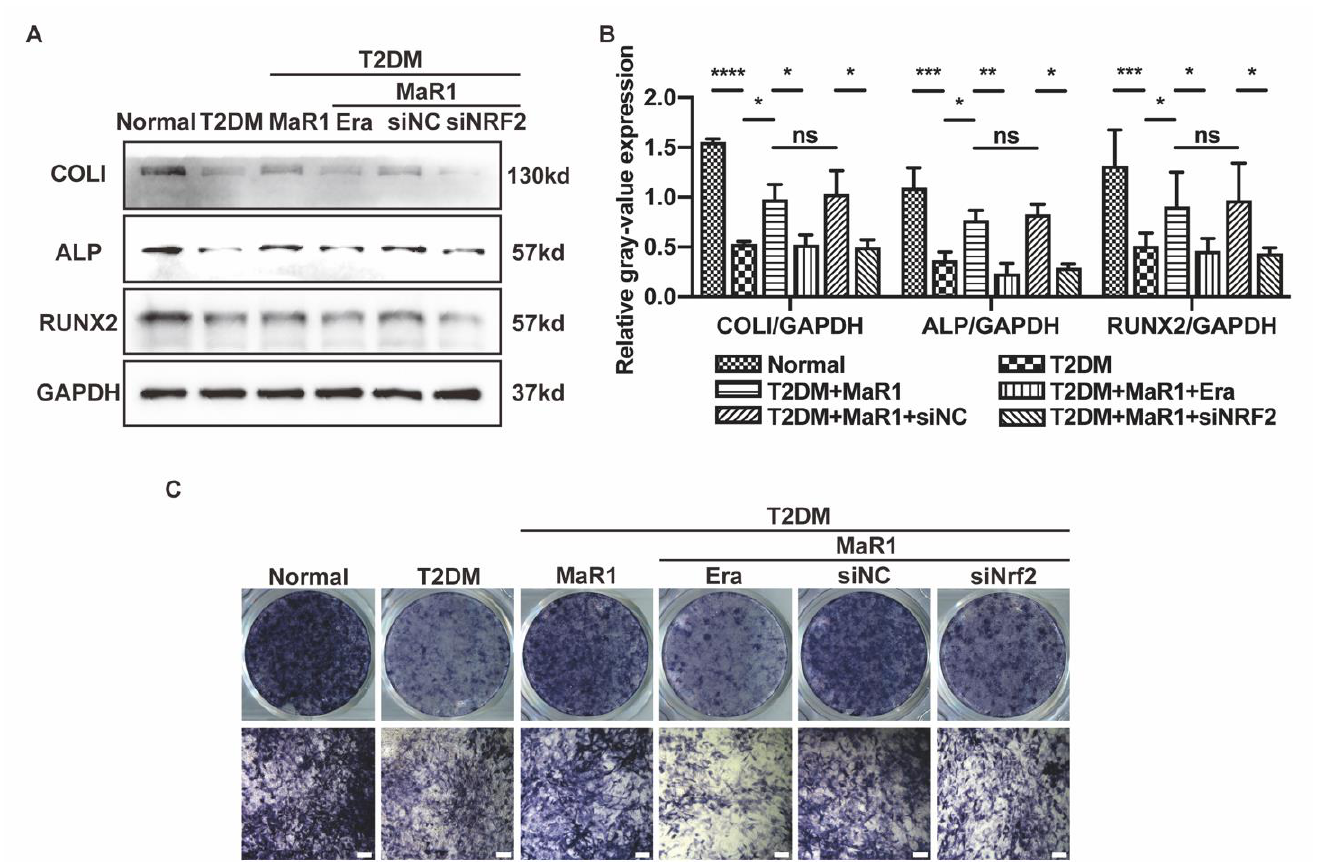
Figure A3. MaR1 protects against ferroptosis-mediated impairment of osteogenic differentiation of osteoblasts by modulating NRF2 signaling in T2DOP. ( A ) After seven days of osteogenic induction, the protein levels of COLI, ALP, and RUNX2 were determined using Western blot analysis. ( B ) Quantification of gray-value expression in the Western blotting. ( C ) ALP staining after seven days of osteogenic induction. Scale bar = 200 μm. Data are presented as the means ± SDs from three separate experiments (n = 3). ns p > 0.05; * p < 0.05; ** p < 0.01; *** p < 0.001; **** p < 0.0001. SiNC: siRNA negative control; siNRF2: siRNA of NRF2.